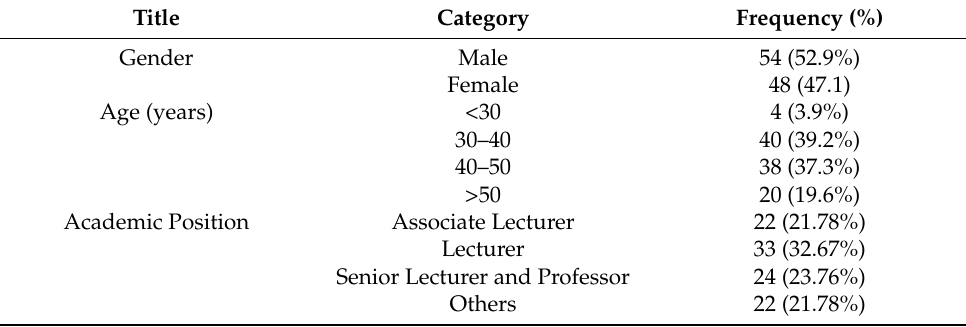
Table 1. Participants in the study in frequency percentage.